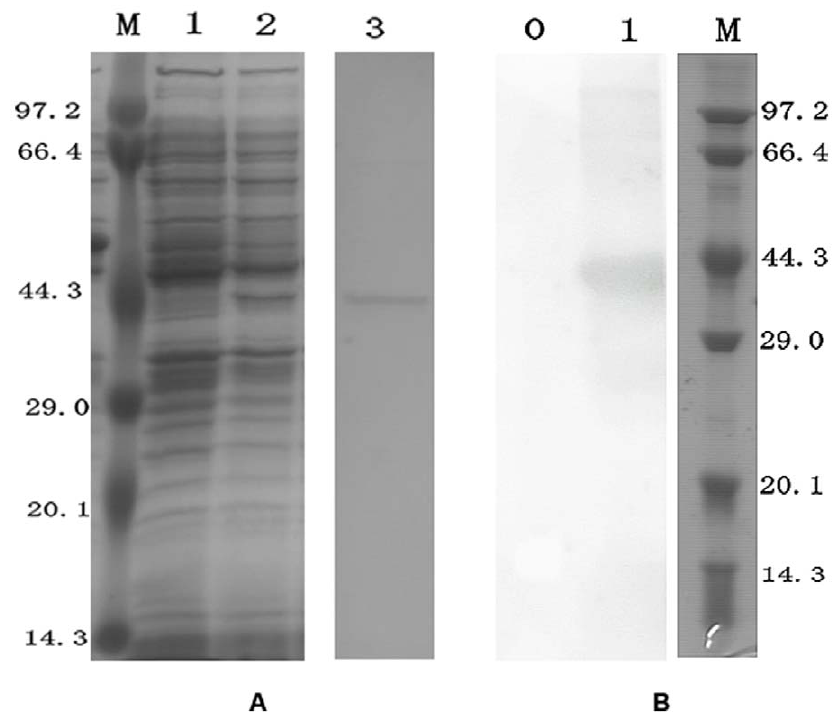
Figure 4. SDS-PAGE and western blotting analysis of Ca-HMGB. (A) SDS-PAGE analysis of pET32a-Ca-HMGB expressed in E. coli Rossetta (DE3. M, Protein mark; 1, No induction; 2, 0.5 mM IPTG induction; 3, Purified Ca-HMGB. (B) Western blotting analysis of anti-CaHMGB (1:5000). 0, pre- immunized rabbit serum; 1, anti-CaHMGB.